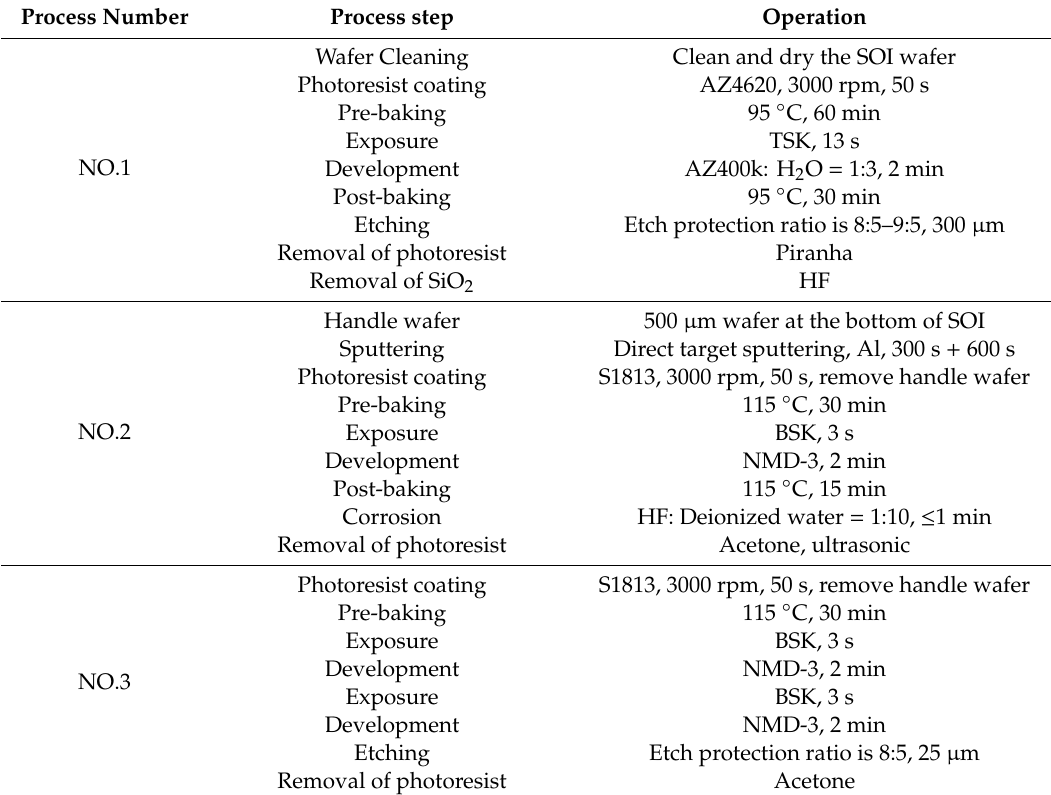
Table 3. Flow and operation of the